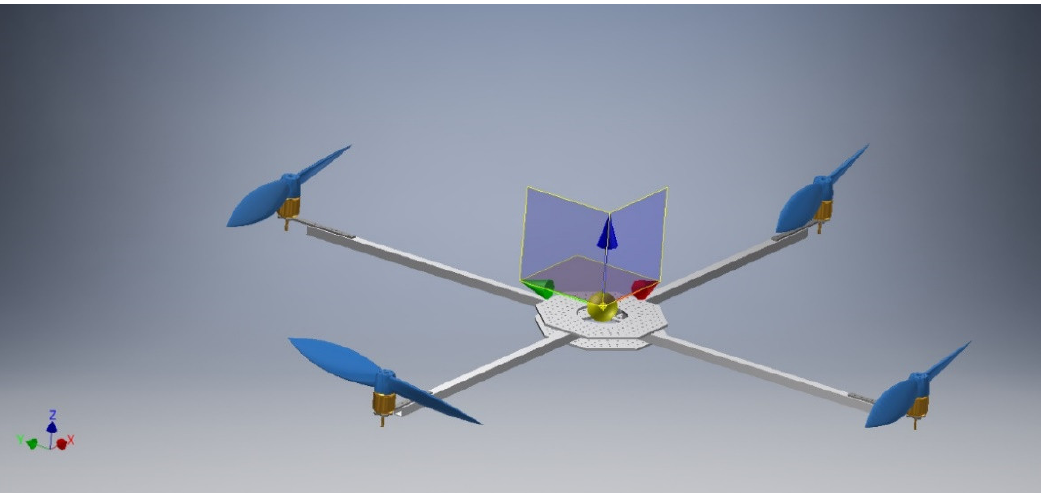
Figure 19. Quadrotor design in Inventor.